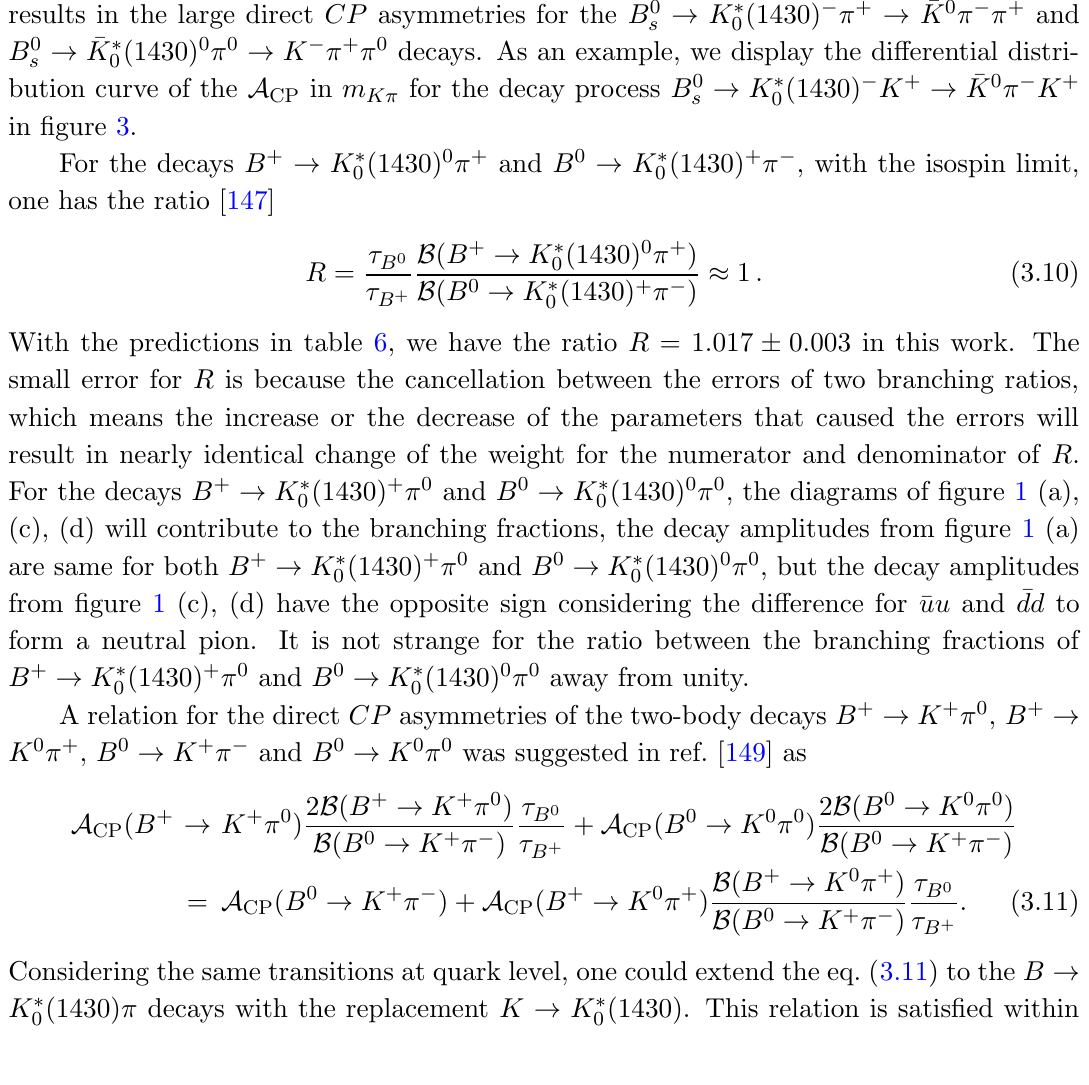
as the intermediate, but not for the decays B 0 (cid:22) K (cid:3) (1430) 0 (cid:25) 0 ! K (cid:0) (cid:25) + (cid:25) 0 via the b ! dq (cid:22) q transition. The interference between the weak 0